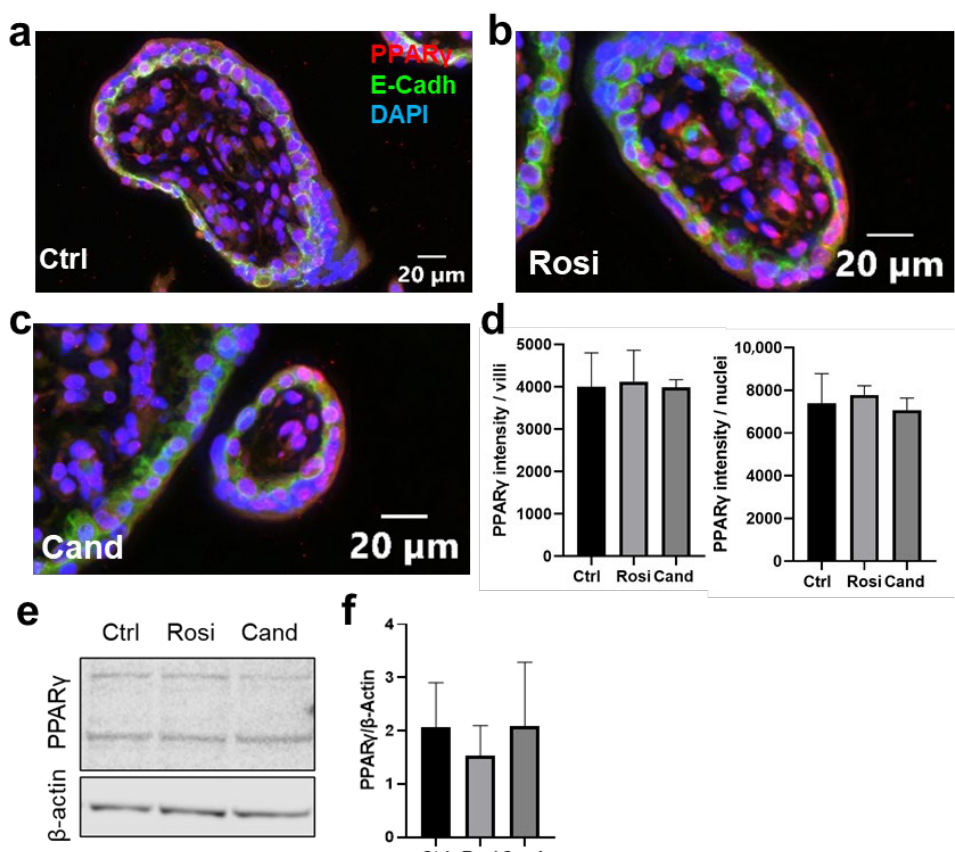
Figure 3. Candesartan has no effect on PPAR γ nuclear translocation in trophoblasts of first-trimester placenta explants. First-trimester placenta explants were treated with ( a ) solvent control (DMSO, ctrl), ( b ) 100 µ M rosiglitazone (Rosi), or ( c ) 10 µ M candesartan (Cand) for 24 h. Stainings are shown on the control (Ctrl), rosiglitazone, and candesartan-treated explants. Nuclei counterstained with DAPI (blue), tissue stained with E-Cadherin (green), and PPAR γ (red). ( d ) Rosiglitazone and candesartan treatment did not affect the intensity of PPARγ intensity on trophoblast cytoplasmic and nuclear areas compared to the control ( n = 4, one-way ANOVA, p = 0.6465). The treatments also did not affect the PPARγ intensity over the villous area ( n = 4, one-way ANOVA, p = 0.9596). ( e ) Western blot analysis of first-trimester explants treated with 100 µM rosiglitazone or 10 µM candesartan for PPAR γ showed two bands. Only the lower ban was used for the analysis at 54–57 kDa. ( f ) Rosiglitazone and candesartan treatments did not affect the PPAR γ protein expression ( n = 4, one-way ANOVA, p = 0.6271).